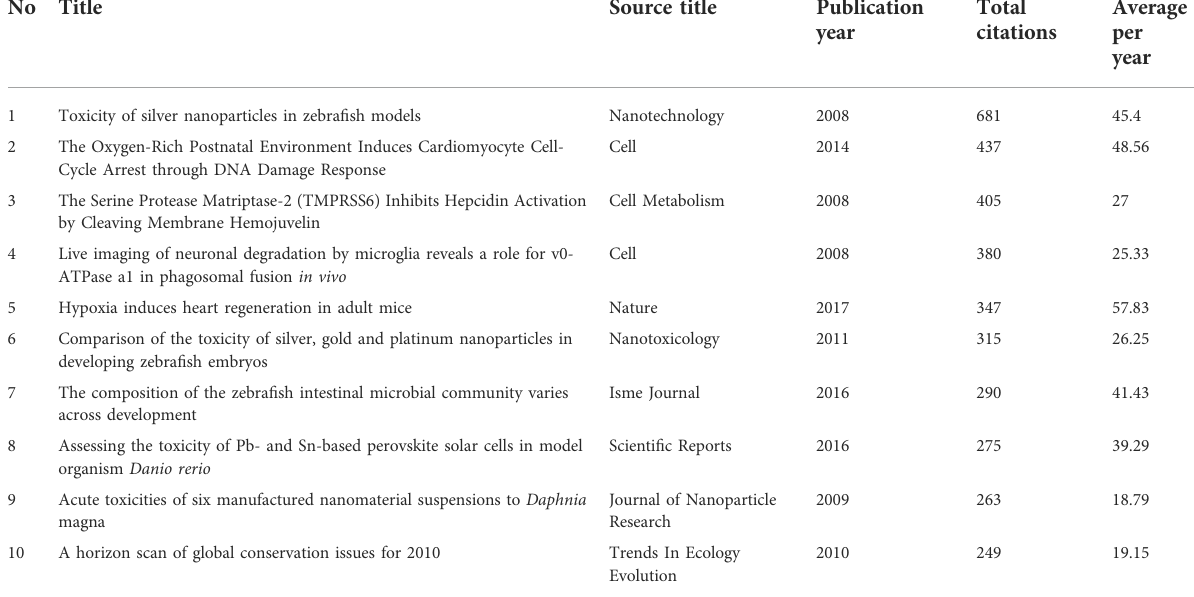
TABLE 2 The top ten articles with the highest number of citations for research on Zebra fi sh and climate